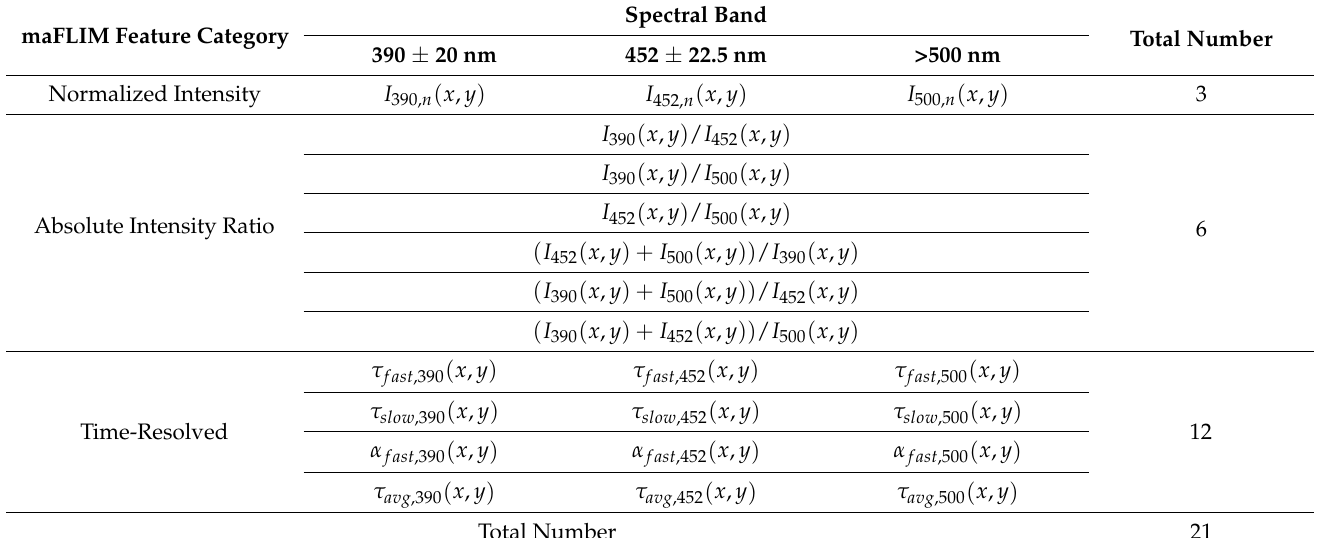
Table 3. Summary of maFLIM-Derived Features Computed Per